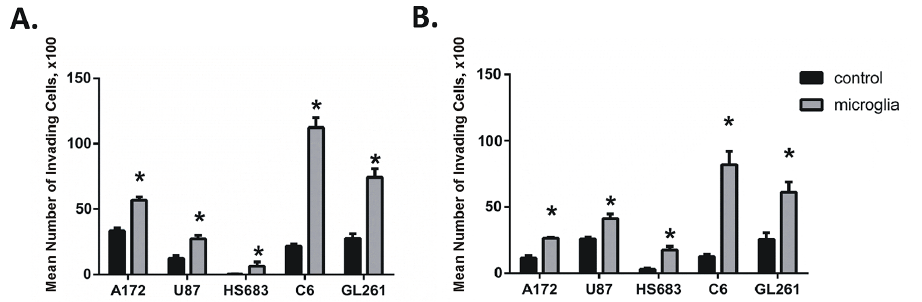
Fig 1. Factors released from microglia increase glioma invasiveness and migration. Invasion (A) and migration (B) assays were performed. Number of invading and migrating glioma cells without (control) and with microglia in the lower compartment. Results are presented as mean ± S.D. with significant differences from controls ( * ) shown (p < 0.05). Unpaired t-tests were used to determine significance between